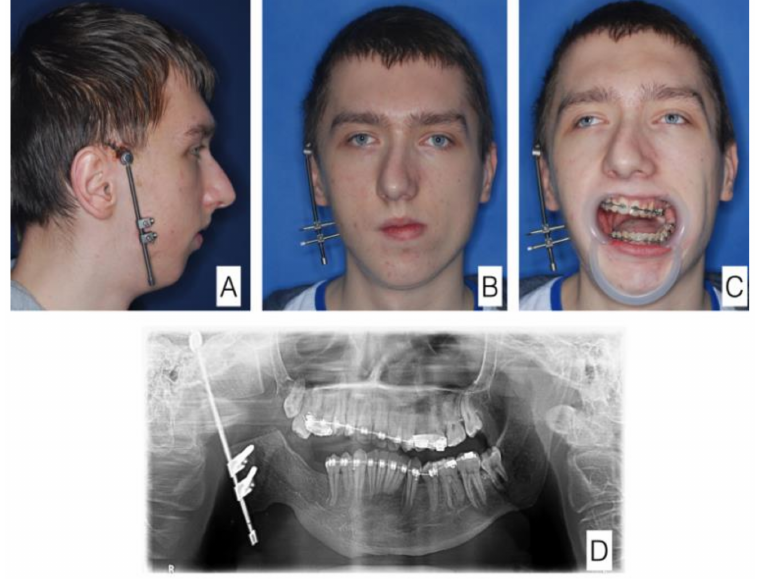
Figure 6. The same patient at a later stage of treatment. In the course of osseodistraction. ( A ) Lateral view of the face, ( B ) anterior view of the face, ( C ) anterior view of the face with mouth open— significant improvement visible. ( D )